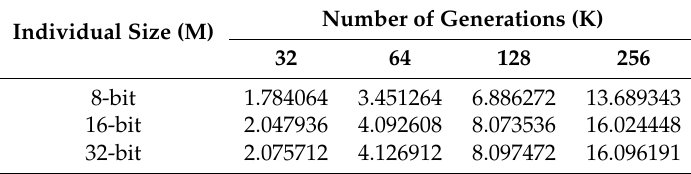
Table 8. Average processing time (in seconds) for different values of K, using f 4 ( ¯x ) with N = 8 and D = 1.